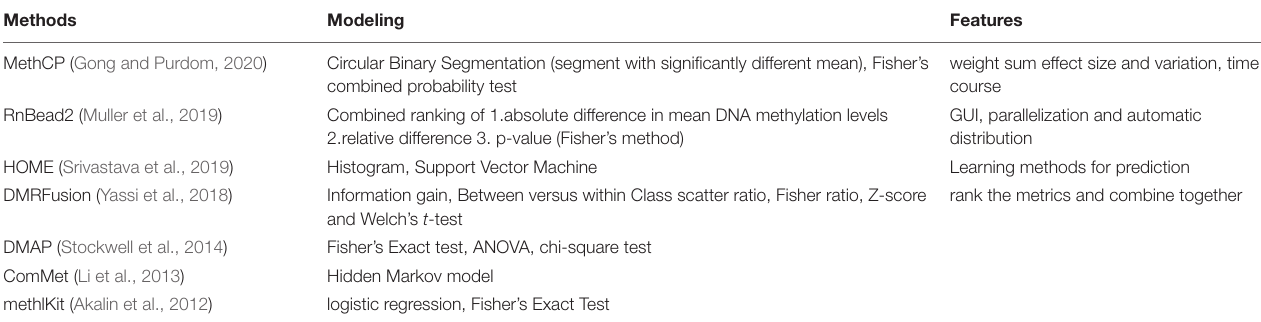
TABLE 4 | DMR methods for bisulfite sequencing.